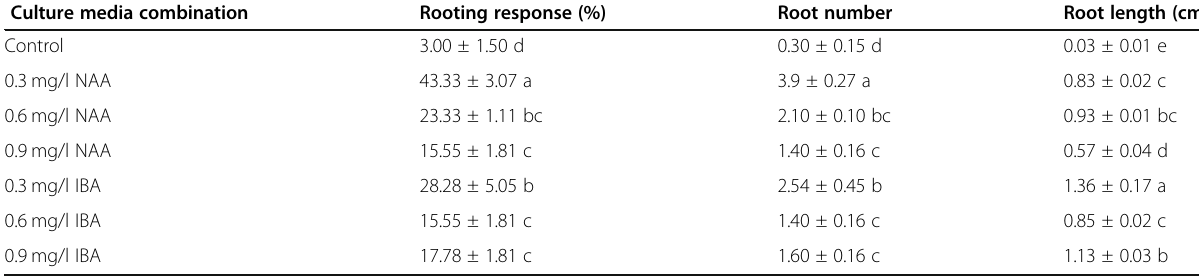
Table 1 Effect of various levels of NAA and IBA on in vitro root induction of Rosa canina Culture media